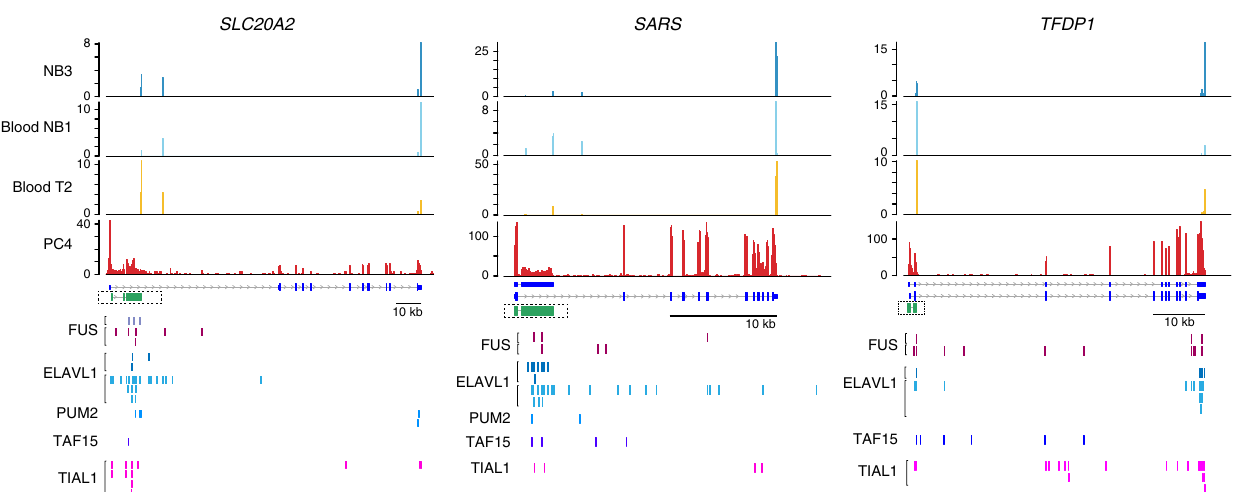
Fig. 5 5 ʹ IpA isoforms potentially express non-coding RNAs. Examples of 5 ʹ IpA isoforms are shown as in Fig. 1b. Also shown is the structure of the assembled IpA isoform transcripts in green. Enrichment of CLIP-seq tags over exonized introns of IpA isoforms are shown for the RNA-binding proteins FUS, ELAVL1, PUM2, TAF15, and